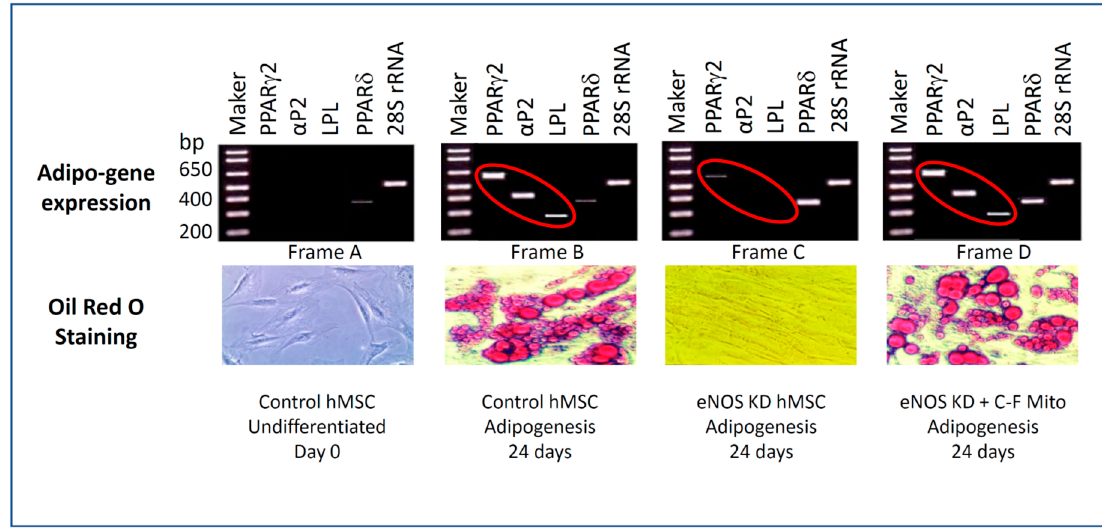
Figure 4. Confirmation of adipogenesis by RT-PCR profiling on the expression of adipogenic genes and Oil Red O staining of lipid droplets.